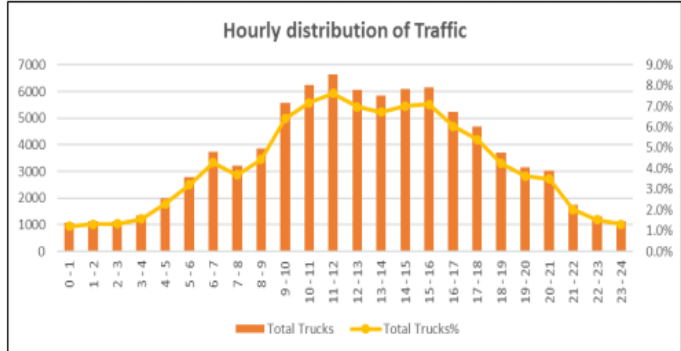
Figure 2: Hourly distribution of freight traffic